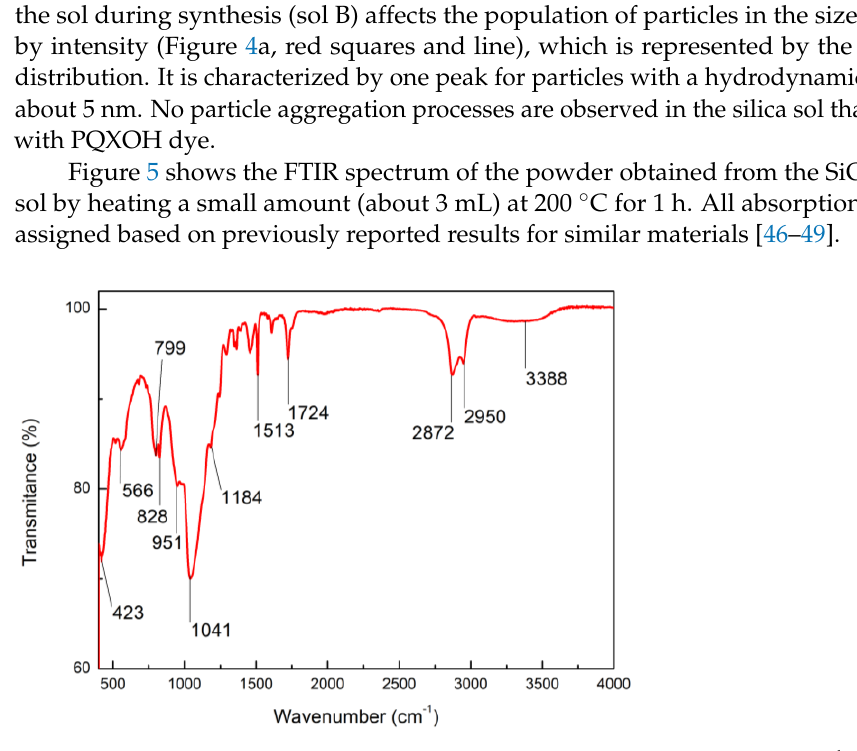
Figure 5 . FTIR spectrum for powder SiO 2 with PQXOH in the range 400–4000 cm −1